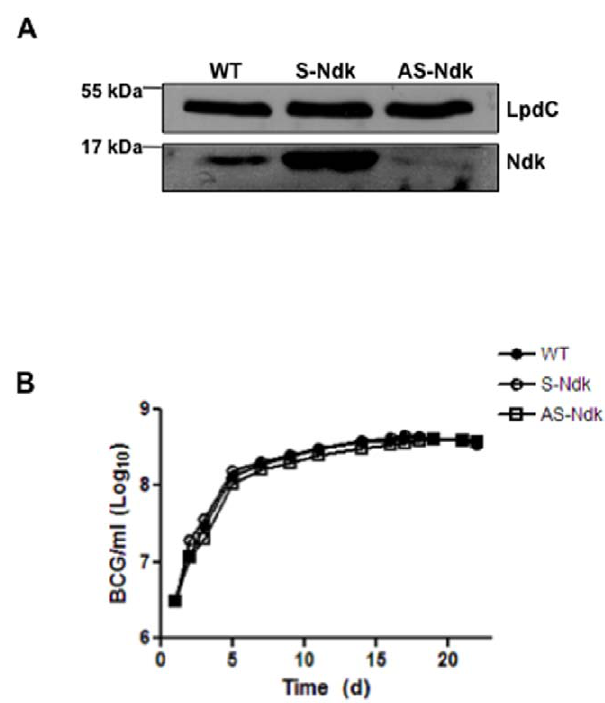
Figure 5. Generation of recombinant BCG with knocked down Ndk expression. A. Wild-type BCG, BCG transformed with pMV261-S- Ndk (sense, overexpression), and BCG transformed with pMV261-AS- Ndk (antisense, knockdown) were lysed as described in Materials and Methods, and subjected to 15% SDS-PAGE, followed by western blot with anti-Ndk antibodies. Mycobacterial lipoamide dehydrogenase C (LpdC) was used as an internal control for equal loading. B. Growth curve of the BCG strains shown in panel A expressed as Absorbance at 600 nm.